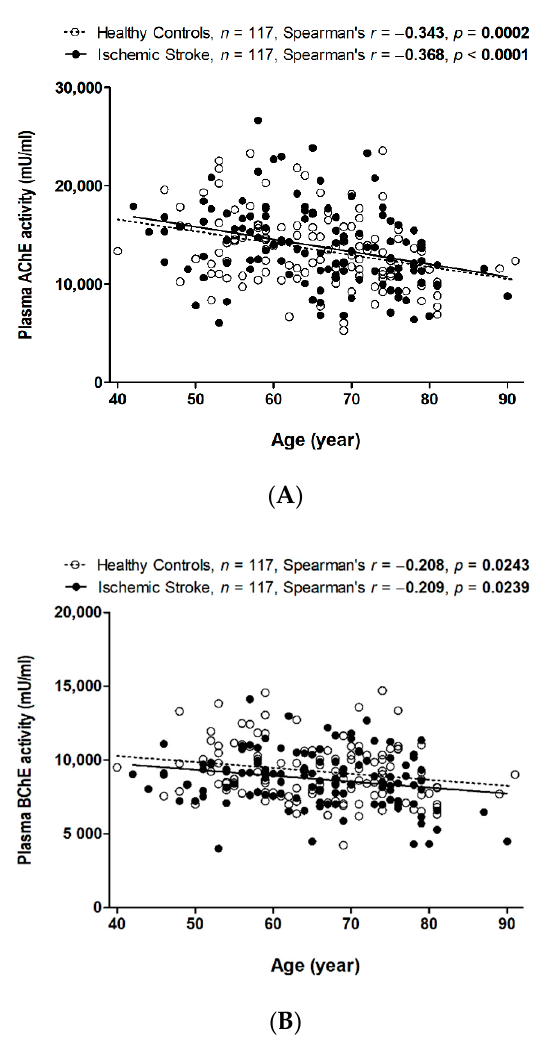
Figure 1. Spearman’s correlation between ( A ) AChE and age and ( B ) BChE activity and age when the patients were separated into healthy controls and patients with IS.